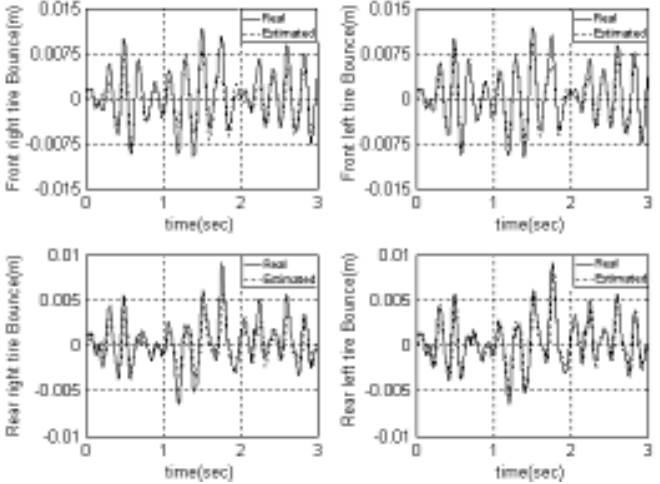
Fig. 2. Comparison of real and estimated states for the front and rear suspension bounces.